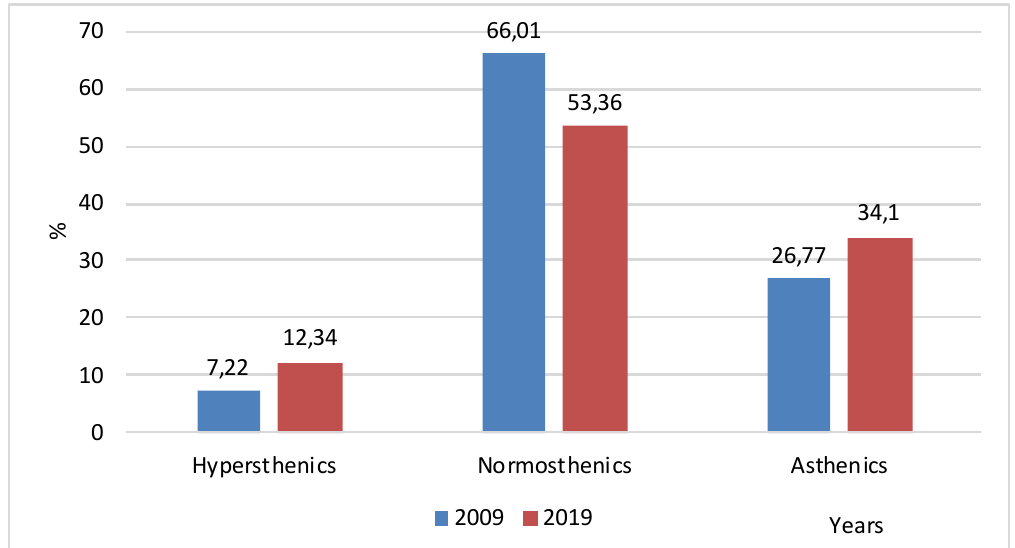
Fig.1. Types of female somatotypes in different years of the